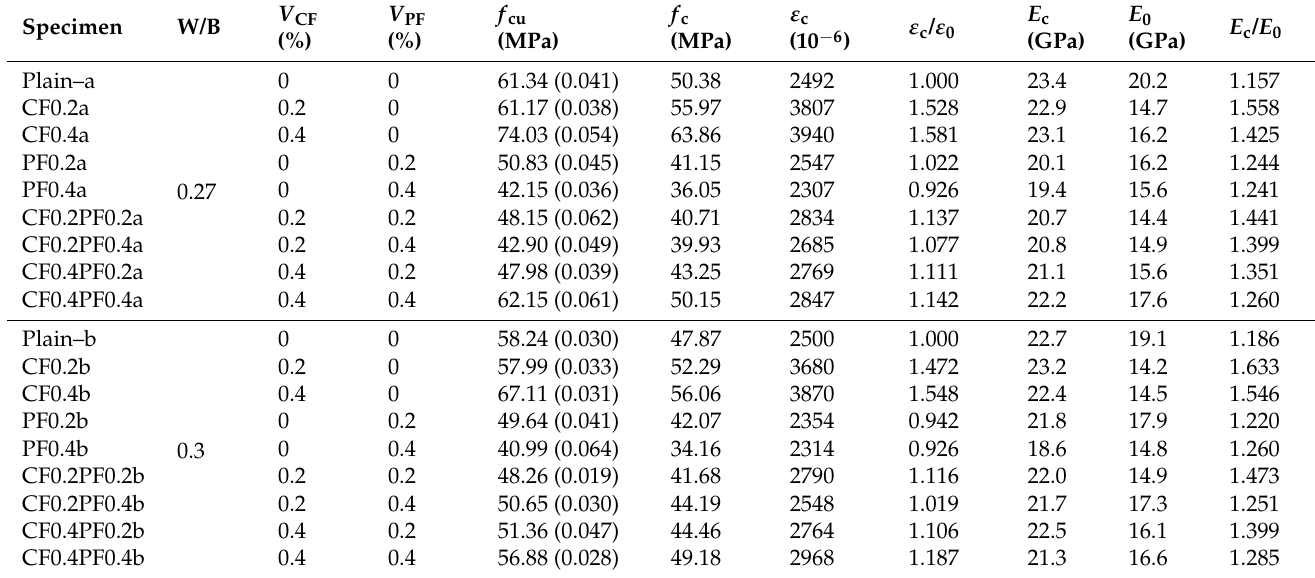
Table 5. Characteristic values of compressive stress–strain curves of